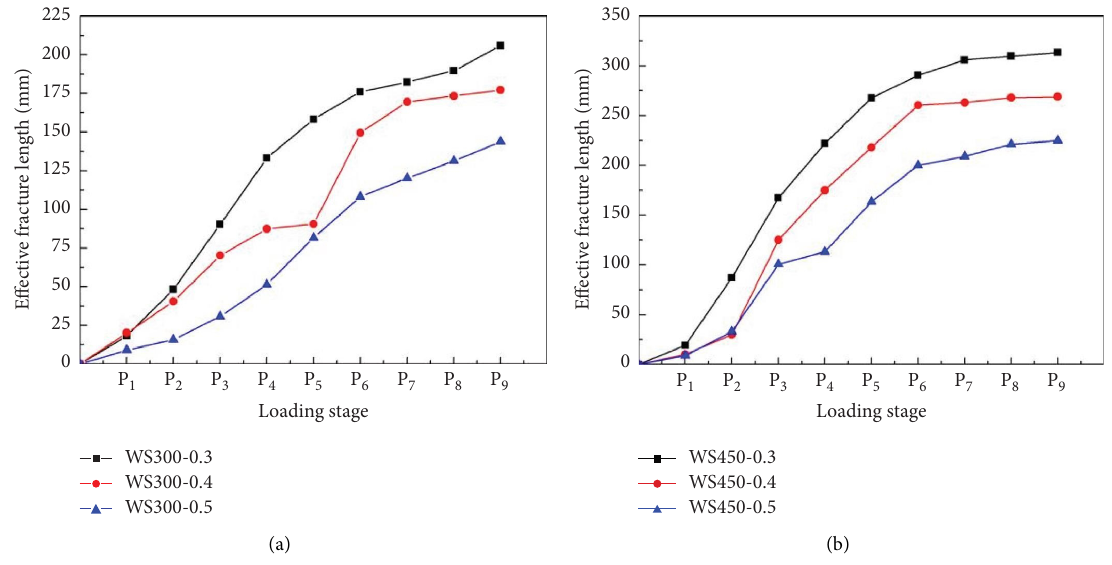
Figure 13: Te variation of the efective crack length with loading stage. (a) WS300. (b) WS450.